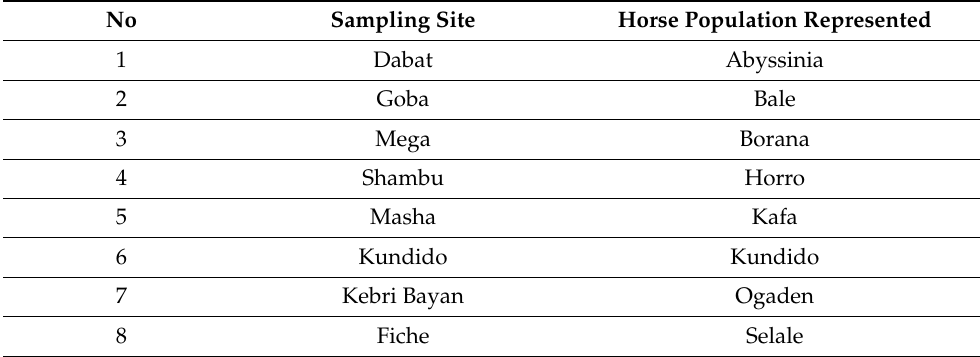
Table 1. Sampling sites and horse populations represented.